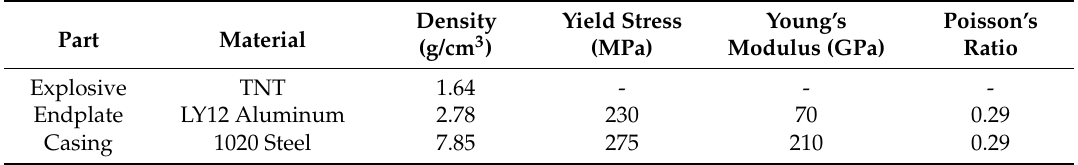
Figure 1. Schematic diagram and sizes of D-shaped devices. ( a ) D-90 ◦ ; ( b ) D-120 ◦ ; ( c ) D-150 ◦ . Table 1. Material properties of the D-shaped